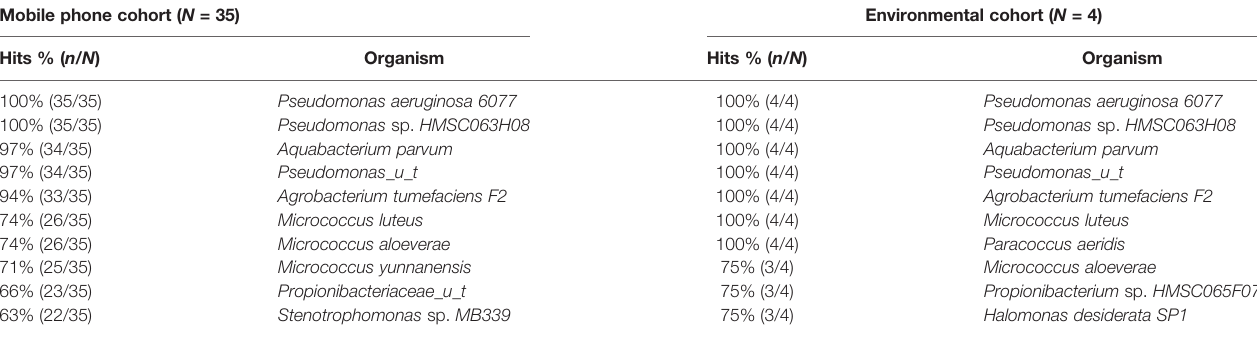
TABLE 3 | Richness of top individual bacterial strain hits found in the mobile phone and environmental cohorts on metagenomic sequencing. Mobile phone cohort ( N = 35)